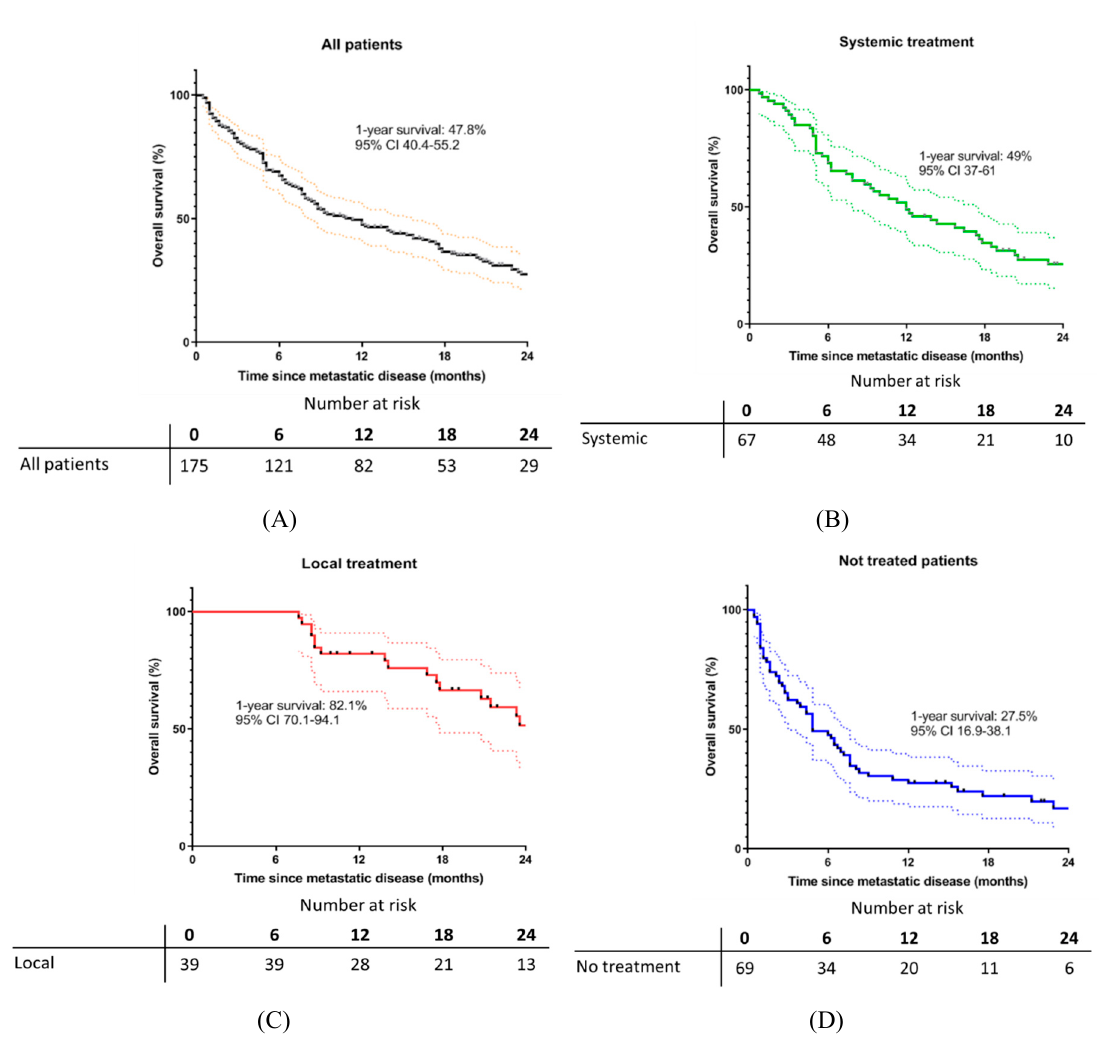
Figure 6. Kaplan-Meier Estimates for all 175 metastatic UM patients and per treatment strategy administered when diagnosed with metastatic disease. ( A ) Kaplan-Meier (KM) estimate for all metastatic UM patients, ( B ) KM estimate for patients treated with systemic therapy, ( C ) KM estimate for patients with local treatment, ( D ) KM estimate for patients receiving no tumor directed treatment (best supportive care.